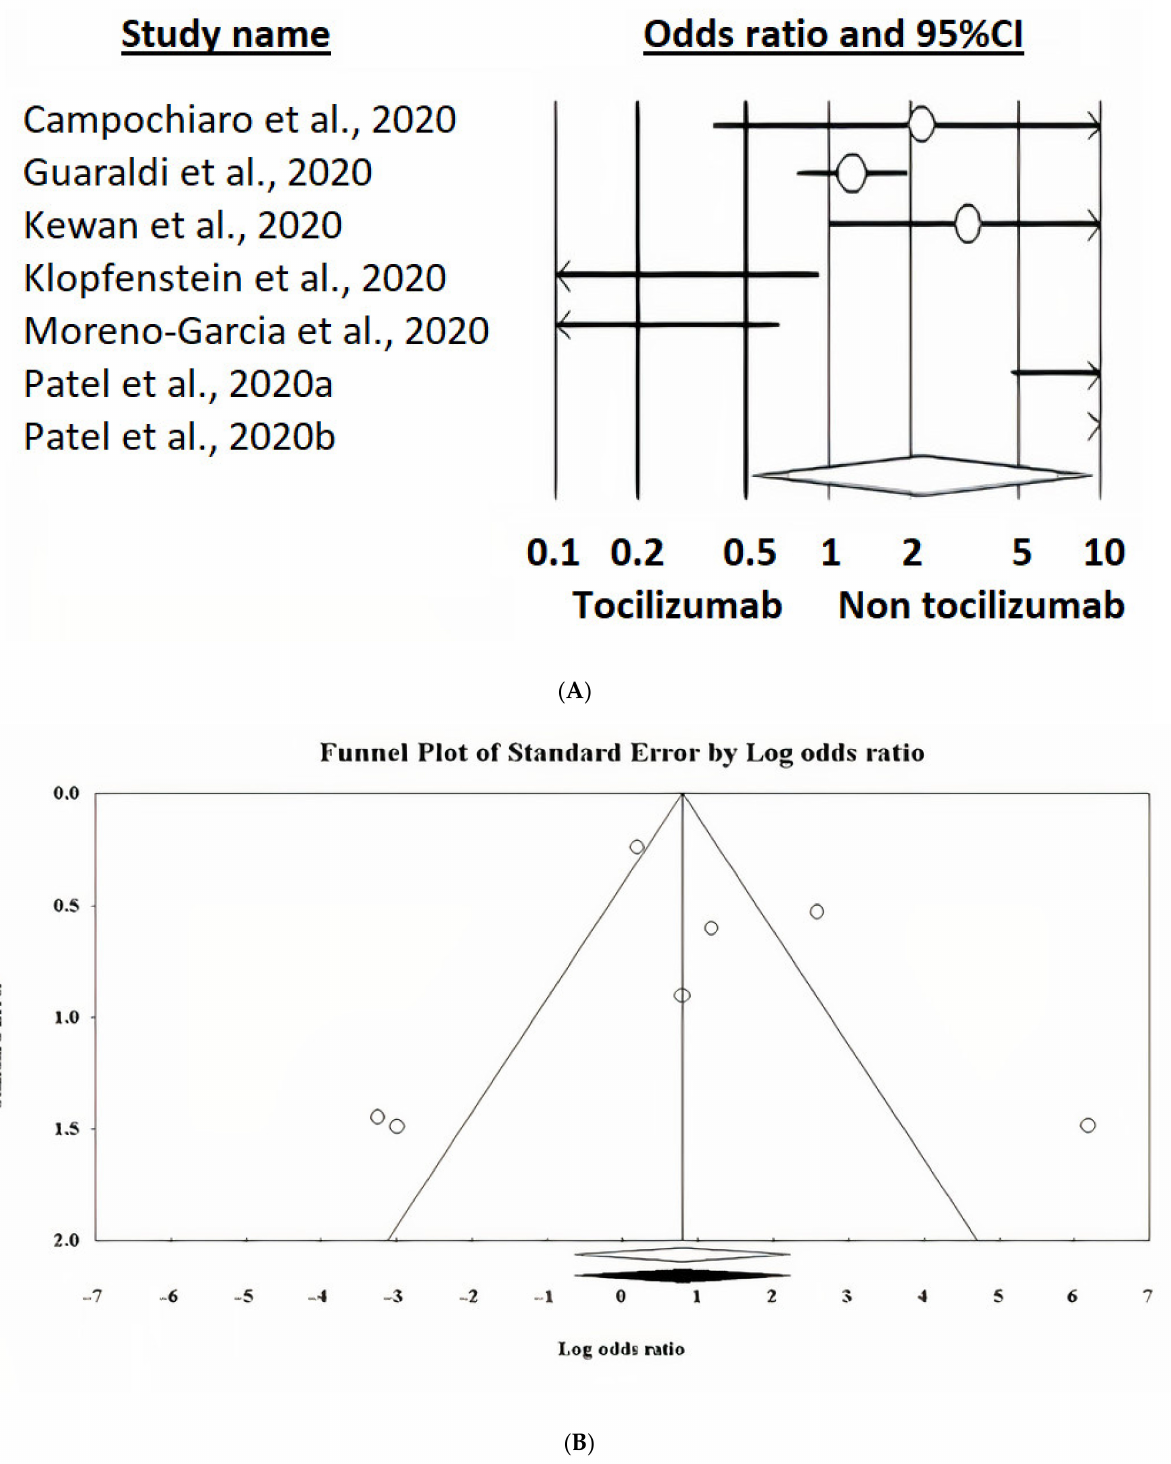
Figure 3. ( A ) Random-effects model forest plot of the impact of tocilizumab on the need for mechanical ventilation in cases receiving tocilizumab plus standard care versus controls not receiving tocilizumab, according to studies reporting unadjusted estimates (crude events). It shows a high amount of heterogeneity among studies and no effect of tocilizumab on ICU admission rate. ( B ) Funnel plot of the random-effects model of the impact of tocilizumab on the need for mechanical ventilation in cases receiving tocilizumab plus standard care versus controls not receiving tocilizumab, according to studies reporting unadjusted estimates. It shows no evidence of publication